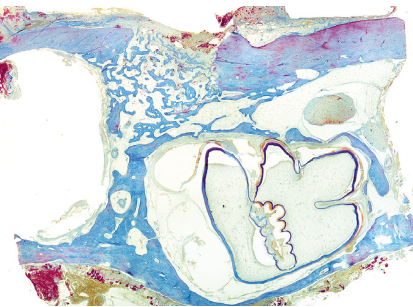
Figure 5: Histotopogram of the rabbit’s mandible cross section 2 weeks after the formation of a bone defect and introduction of a suspension of calcium hydroxide with nanodispersed cerium dioxide.